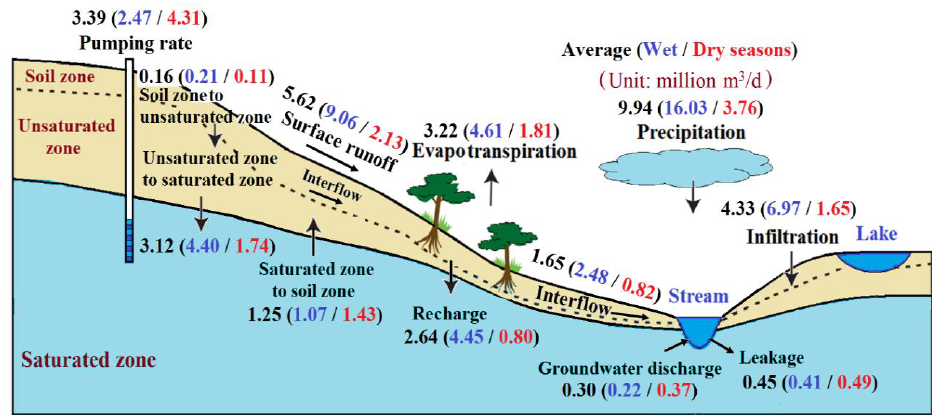
Figure 11. The water budgets for the water cycle components in the PPGB. Note that the blue and red colors represent the wet and dry seasons.